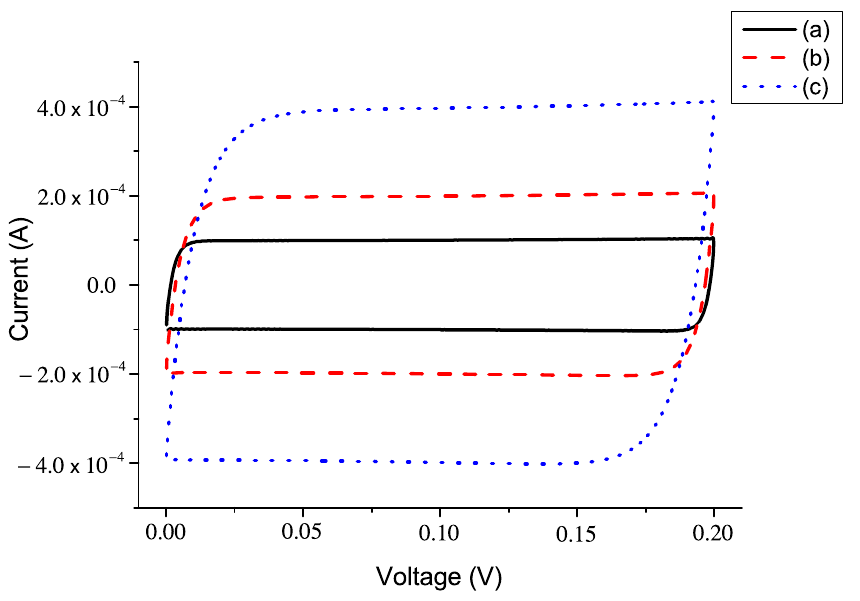
Figure 3. Parametric curves I ( V ) for an electrolytic cell with identical electrodes having the same adsorption properties for positive and negative ions, when the screening parameter is b = 0.04. The adsorption coefficient is 10 − 6 m/s. Desorption times are 0.5 s (a), 1 s (b), and 2 s (c).